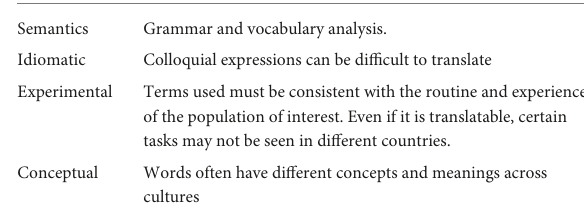
TABLE 3 Stage IV of translation and adaptation: